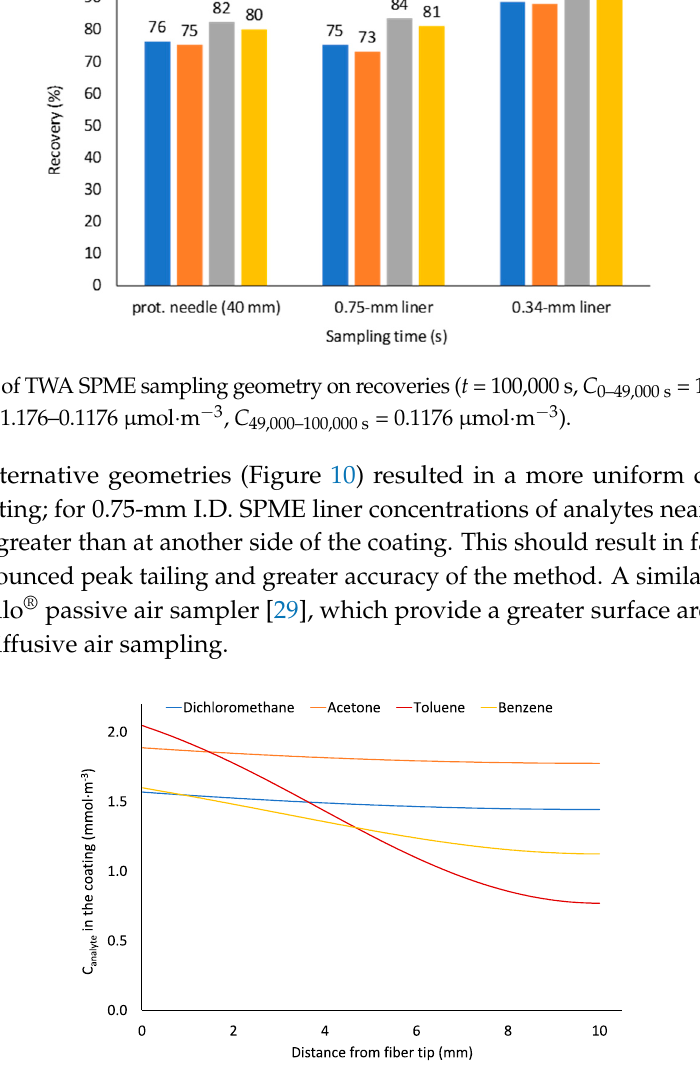
Figure 10. Profiles of analyte concentration in the Car/PDMS coating after sampling ambient air ( C 0–49,000 s = 1.176 μ mol·m − 3 , C 49,000–51,000 s = 1.176–0.1176 μ mol·m − 3 , C 49,000–100,000 s = 0.1176 μ mol·m − 3 ) for 100,000 s using the geometry presented in Figure 8a.